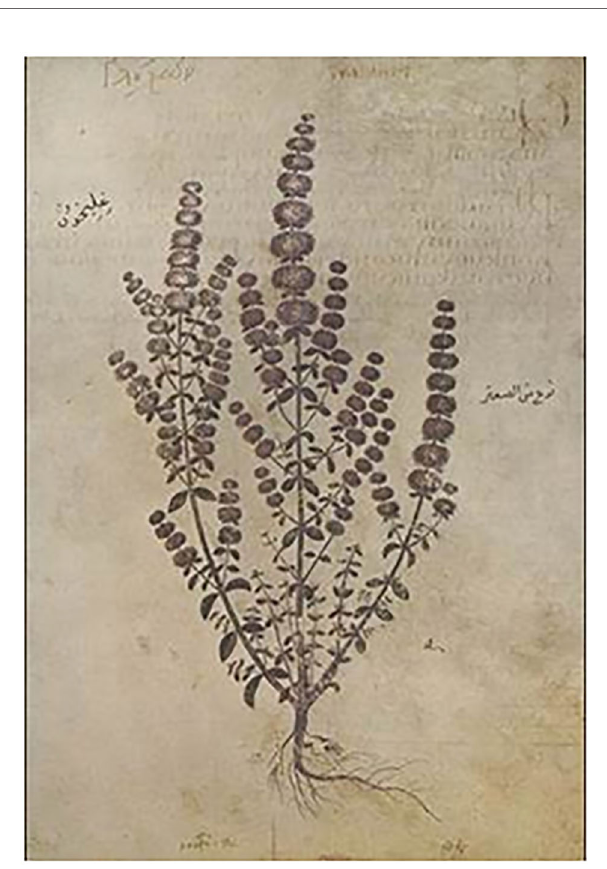
FIGURE 4 | M. pulegium , pennyroyal, Ḡ le ḵ on , gl ή c ο n Vienna Dioscorides, Juliana Anicia Codex, dating to 512 CE. This illustration is Book III, plate 31. The Arabic writing on the right is translated “ type of thyme ” . The Arabic on the left is the translation of Ḡ le ḵ on. The faded Byzantine Greek in the background is translated by L. Beck ( Table 1